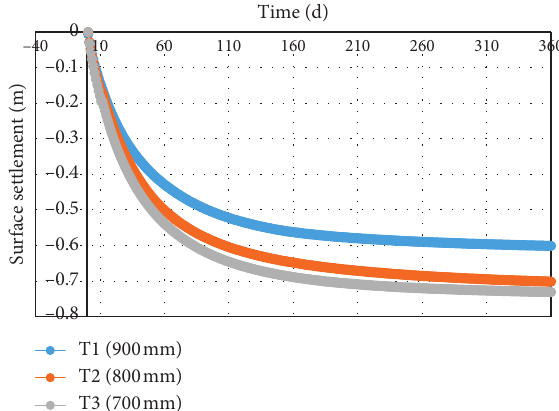
Figure 14: Surface settlement from different computational